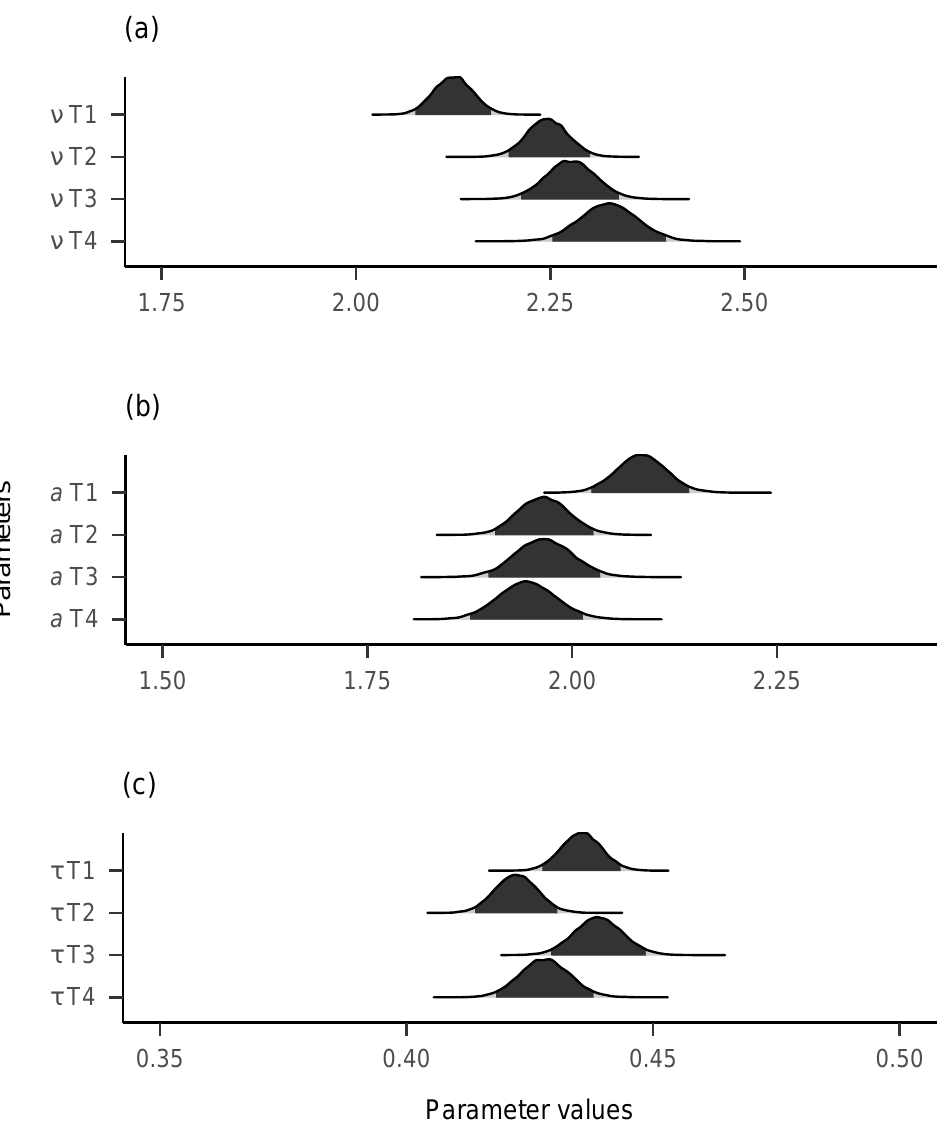
Figure 5. Group-level posterior plots of diffusion model parameters across time. ( a ) = Drift Rates. ( b ) = Boundary Separations. ( c ) = Non-Decision Times. The 95% highest density intervals are shown. T2 = T1 + 6 months. T3 = T1 + 12 months. T4 = T1 + 24 months. Latent slope loadings at T3 and T4 were estimated as 1.142 and 1.297. Both the mean level (intercept) of the latent intercept parameter and of the latent slope parameter were estimated as positive and their 95% credibility intervals (CIs) did not include zero. This indicates that drift rates were generally positive at T1 (as would be expected) and tended to increase over time. The latent intercept showed considerable variance, indicating that people differed in their speed of information accumulation at T1. The latent slope parameter also indicated variance, meaning that people differed in their developmental patterns of drift rates across time—the 95% CI did not include